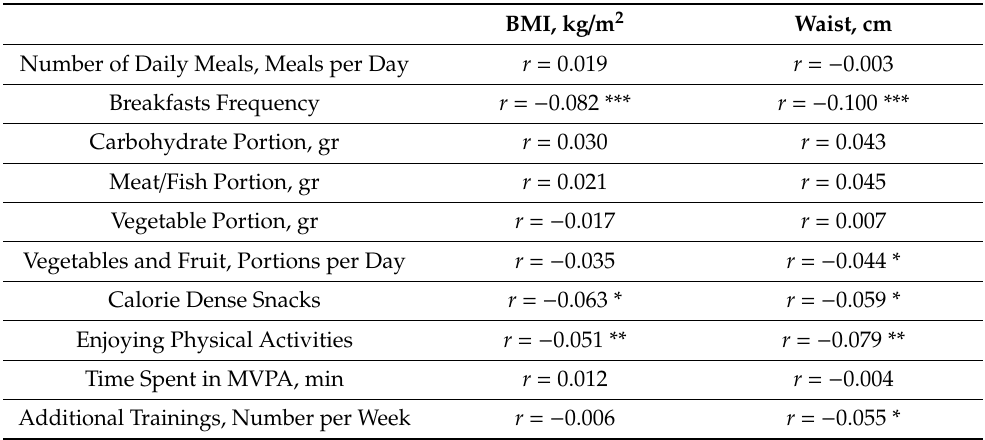
Correlation coe ffi cients characterizing relations between independent (measures) and dependent (anthropometric measurements)